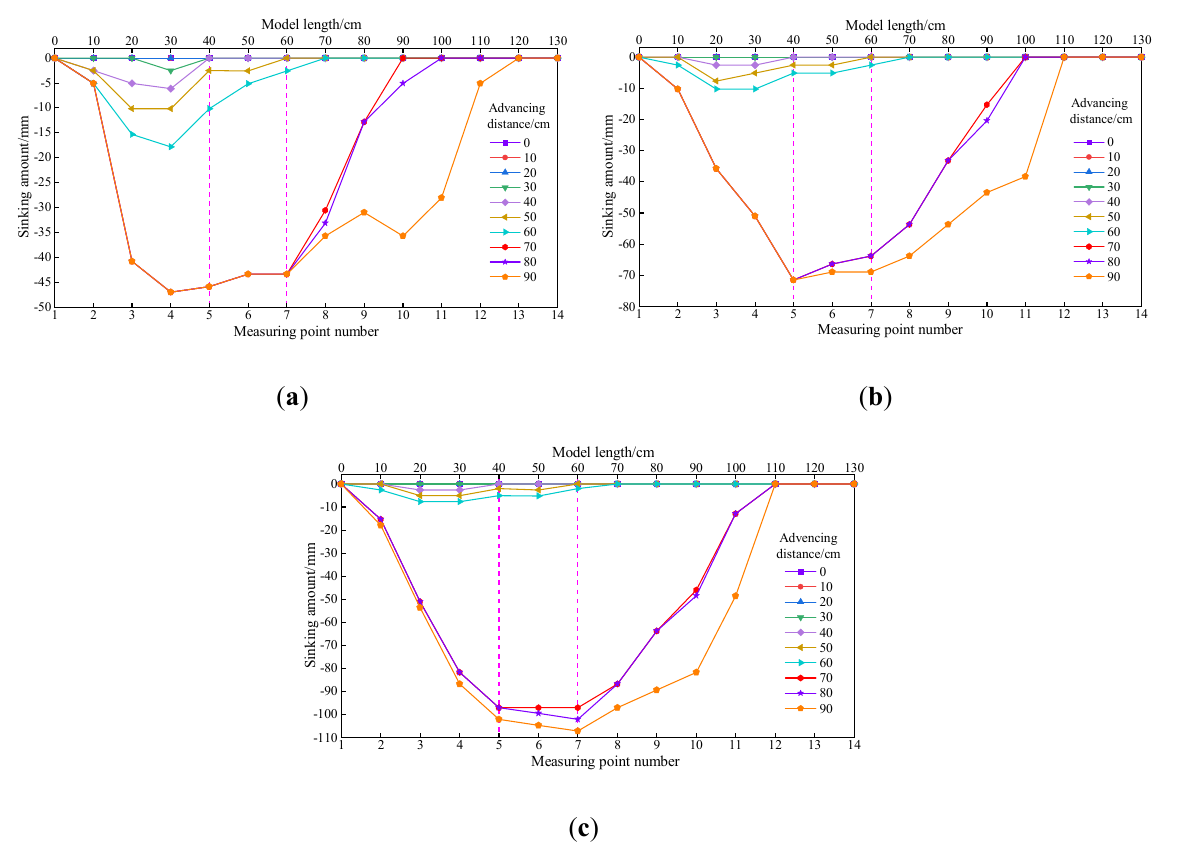
Figure 8. Coal seam roof subsidence of ( a ) No.6, ( b ) No.4, and ( c ) No.3 during model excavation.